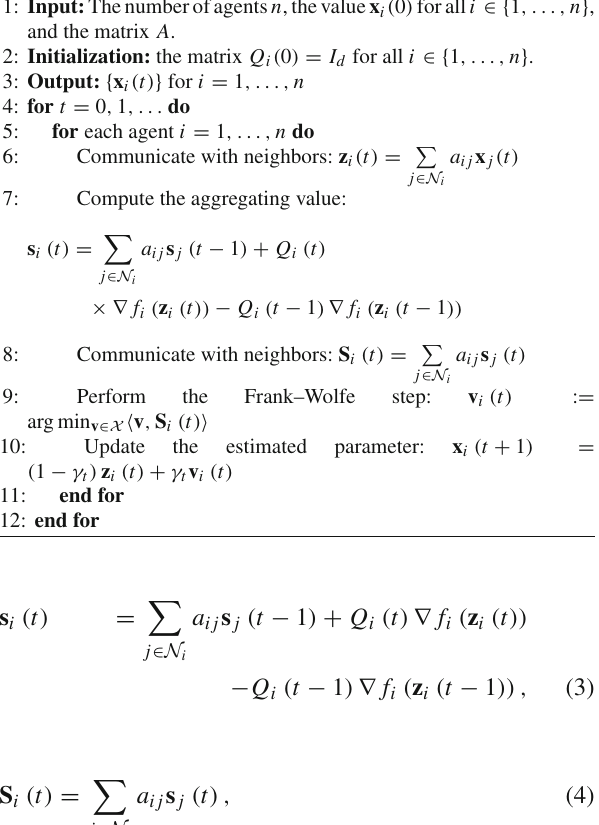
Algorithm 1 Distributed randomized block-coordinate projection-free algorithm over